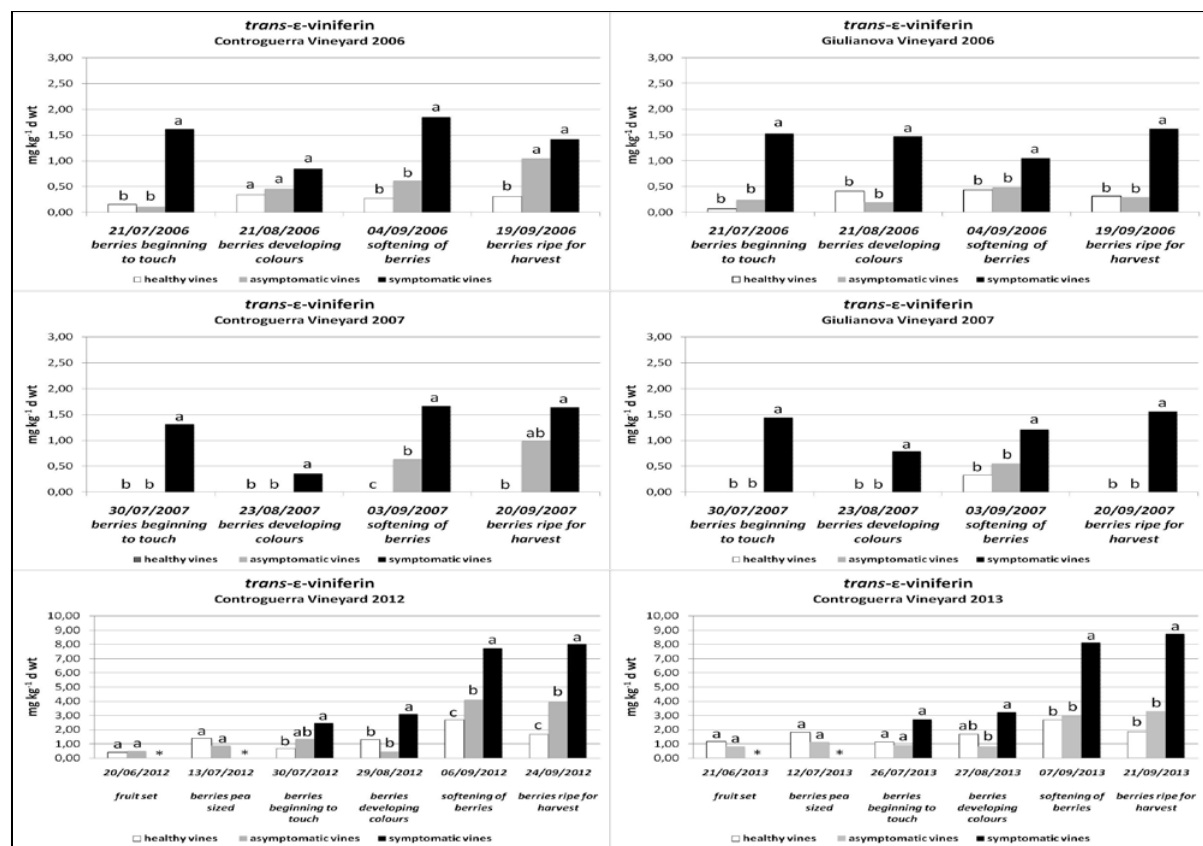
Figure 5. Levels of trans -ε - viniferin in the leaves of vines affected with GLSD and in leaves of healthy vines at various growth stages in the 2006, 2007, 2012 and 2013 growing seasons in the Controguerra and Giulianova vineyards. Statistical analysis was performed according to Tukey’s honest significant difference (HSD) test. Each grapevine category (symptomatic, asymptomatic and healthy) comprised 6 replications of leaf data (1 replication = 1 vine) in each growth stage, in each year and in each vineyard. Different letters represent significant differences at P = 0.05. * = no symptomatic vines found;